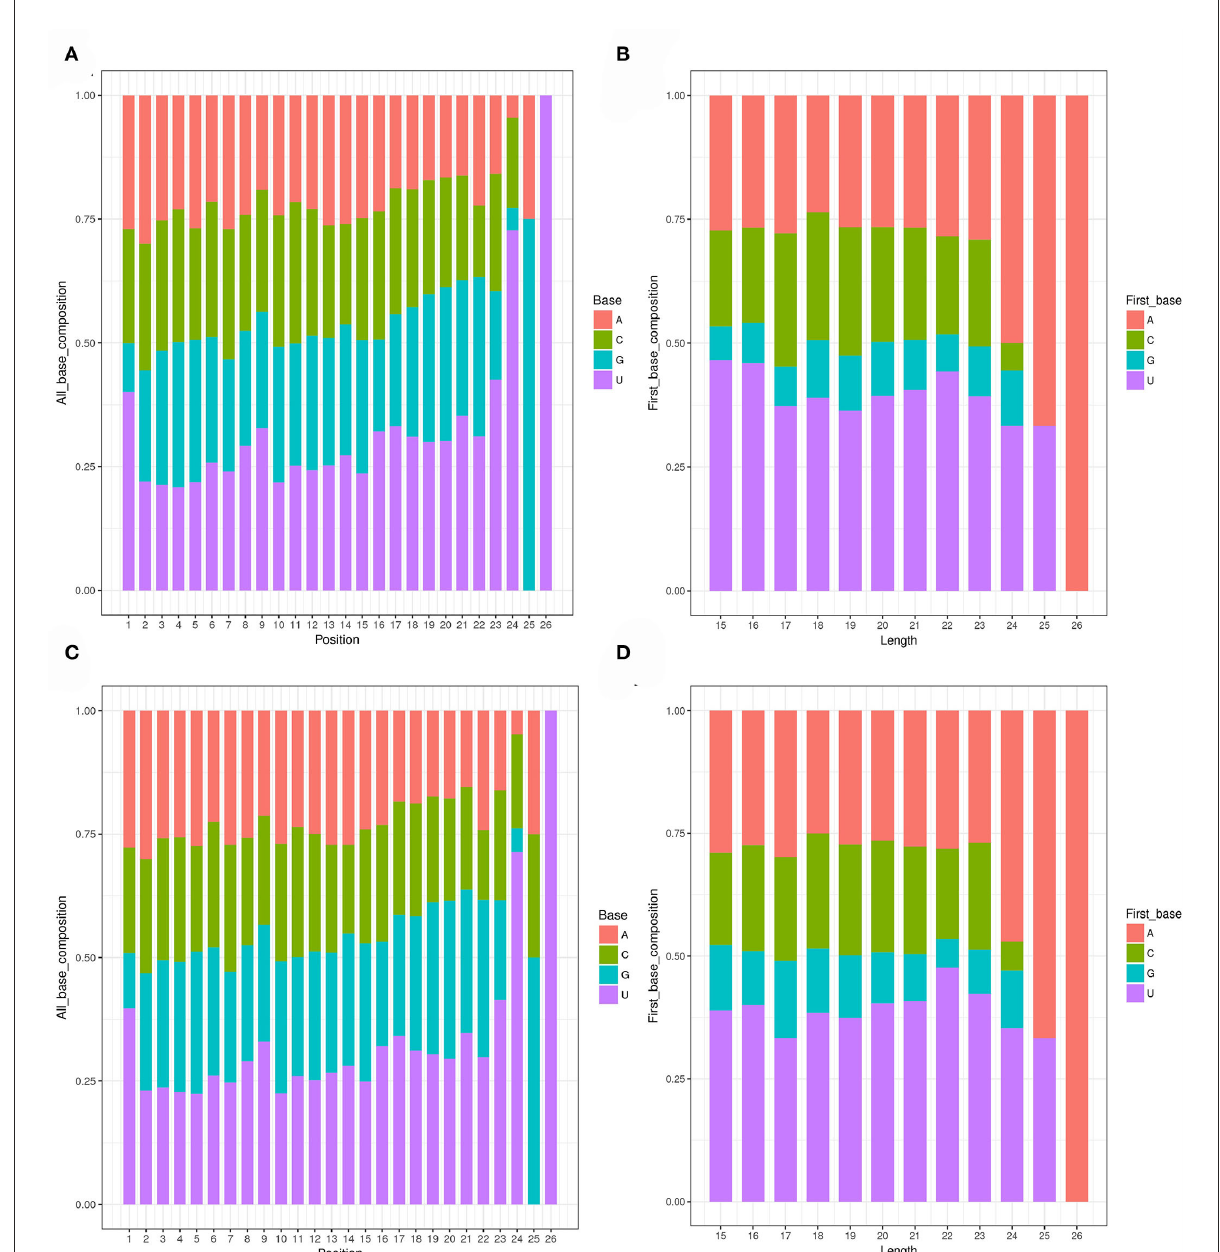
FIGURE2 Structural characteristics of miRNAs. (A) Distribution map of base preference at different miRNA site in L_JN. (B) First base preference distribution map of miRNAs with lengths in L_JN. (C) Distribution map of base preference at different miRNA site in L_PX. (D) First base preference distribution map of miRNAs with lengths in